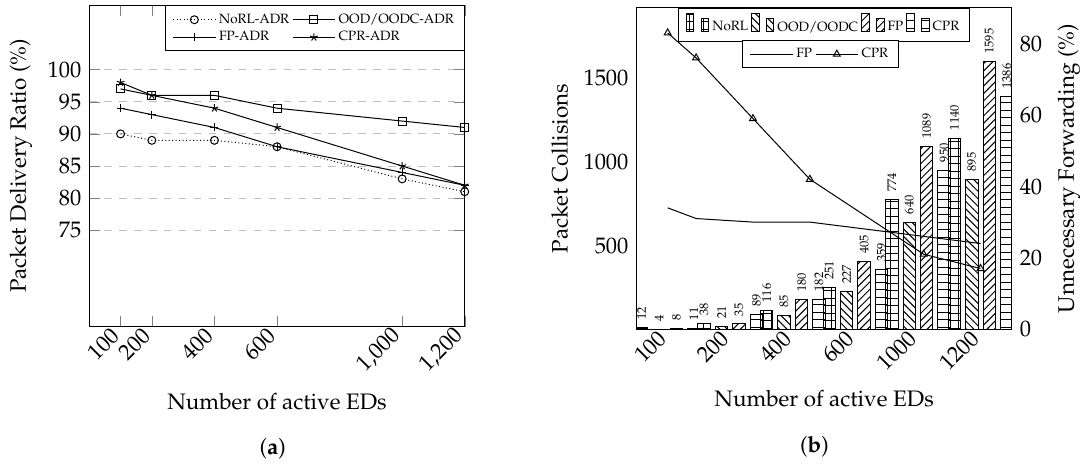
Figure 9. Performance evaluations on network topology 2. ( a ) PDR results. ( b ) The number of packet collision and unnecessary forwarding.